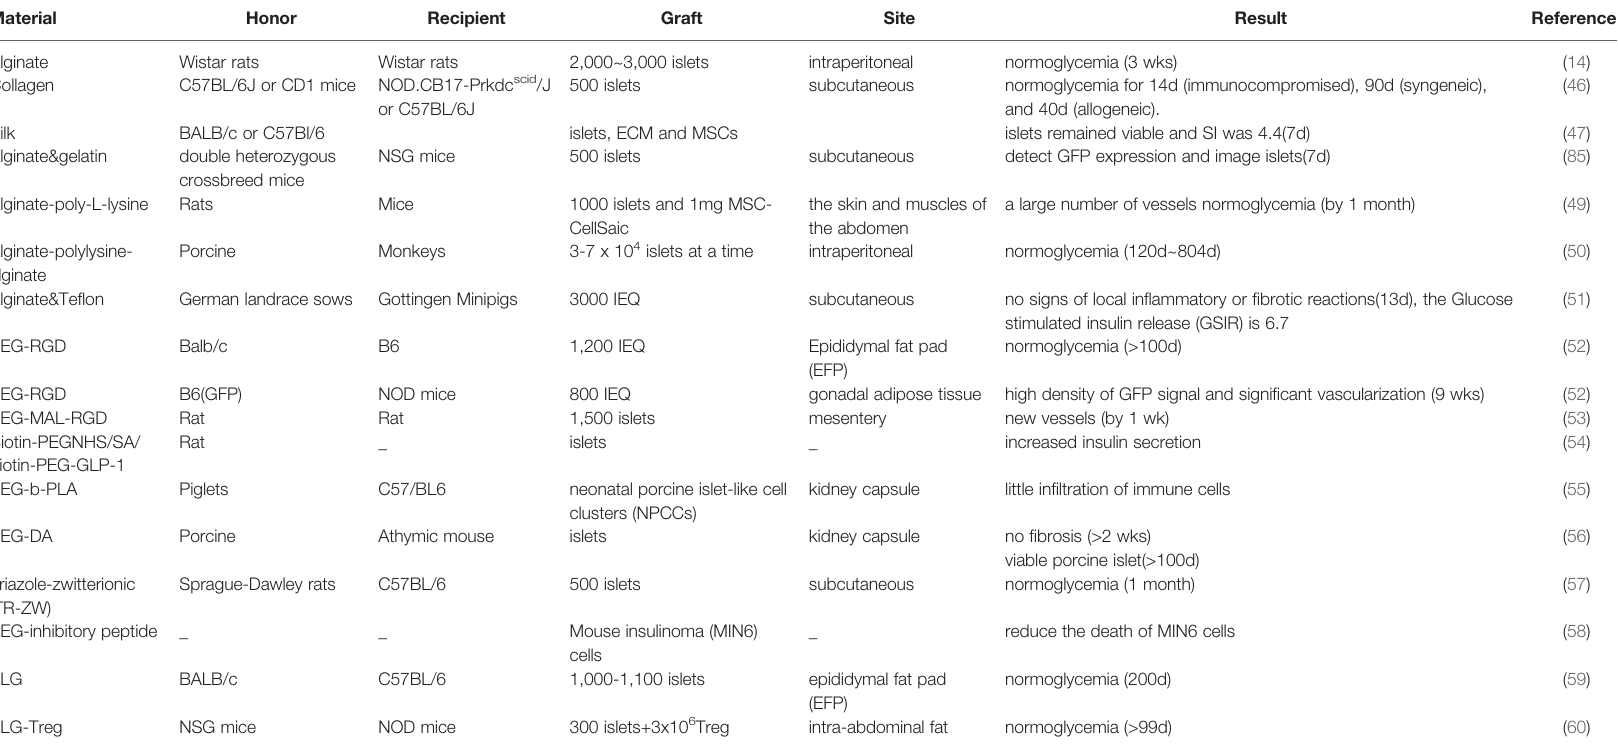
TABLE 1 | Hydrogels as biomaterials for cell